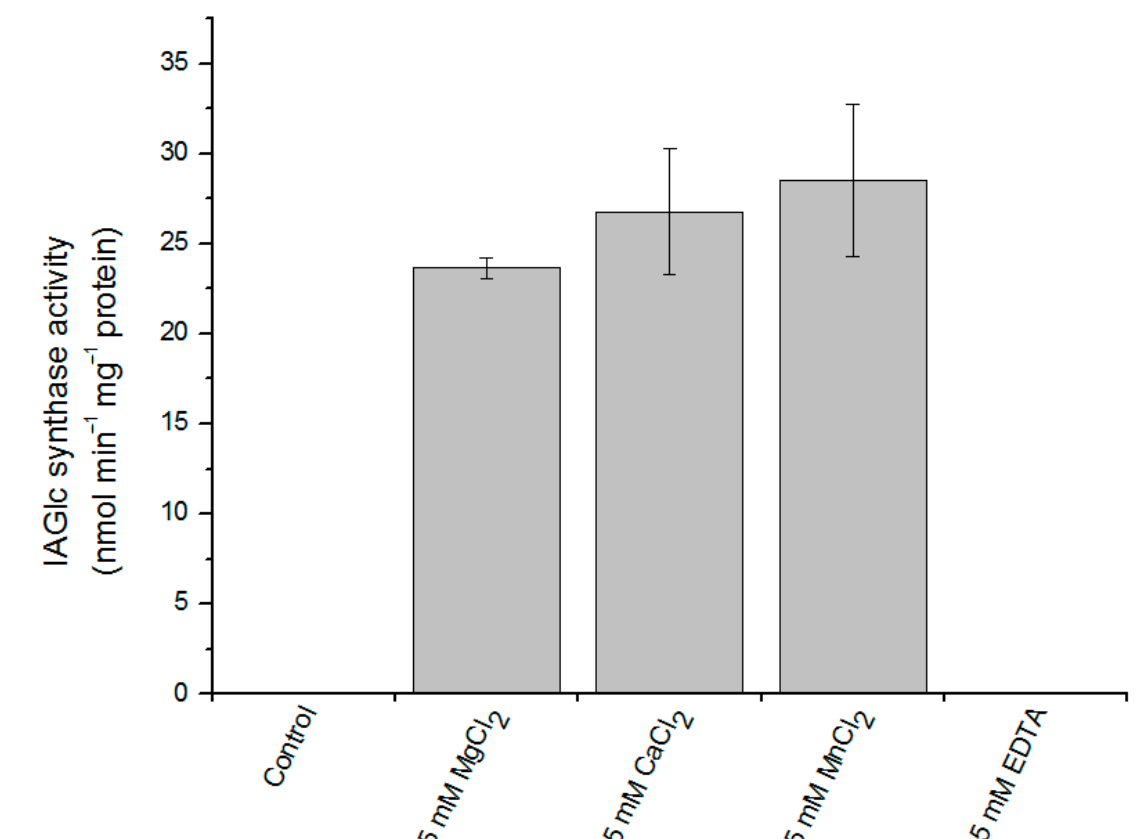
Figure 4. Effect of divalent cations on IAGlc synthase. Enzyme activity was determined using [ 14 C]IAA after TLC in the presence of 5 mM MgCl 2 , 5 mM CaCl 2 , 5 mM MnCl 2 or 5 mM EDTA; the control mixture did not contain any divalent cations. Catalytic activity was expressed as the means ± SD for three repetitions.